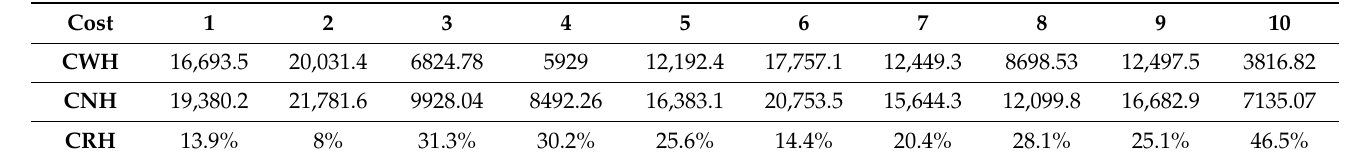
Table 4. Computational results of the second instances set in Case 1.